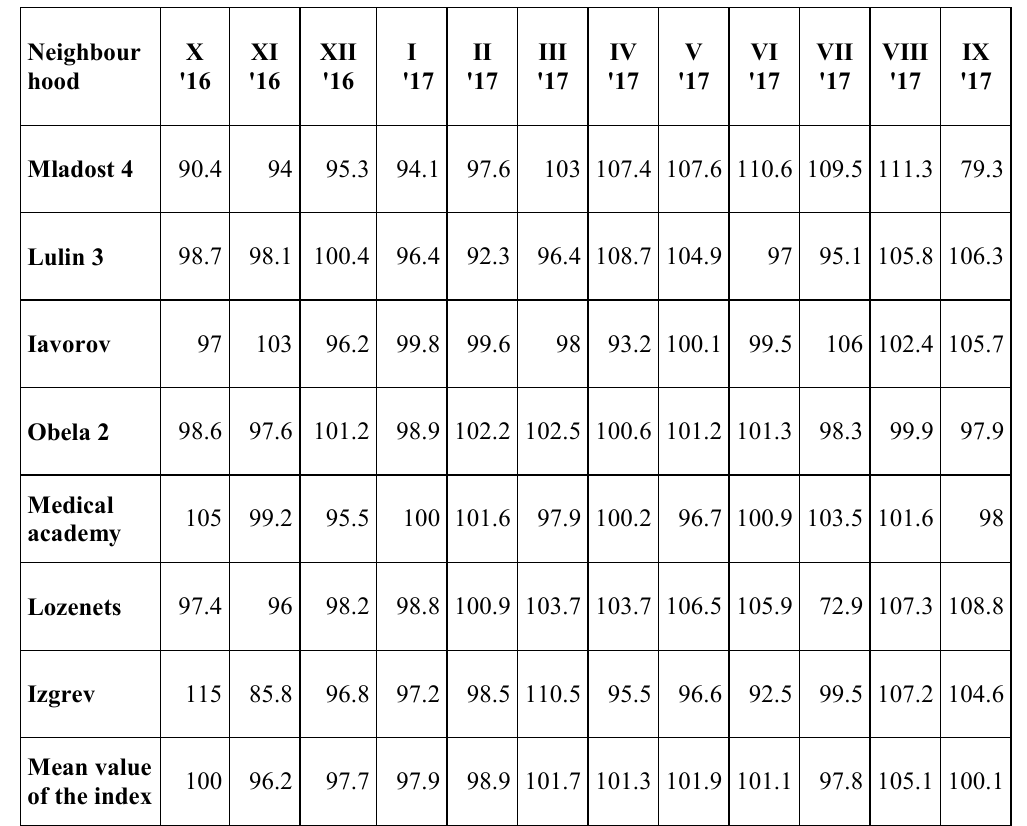
Table 2. The indices of seasonality in the change of the offered prices for sale of one-bedroom flats for a group of neighbourhoods in Sofia in % (developed by the authors, using